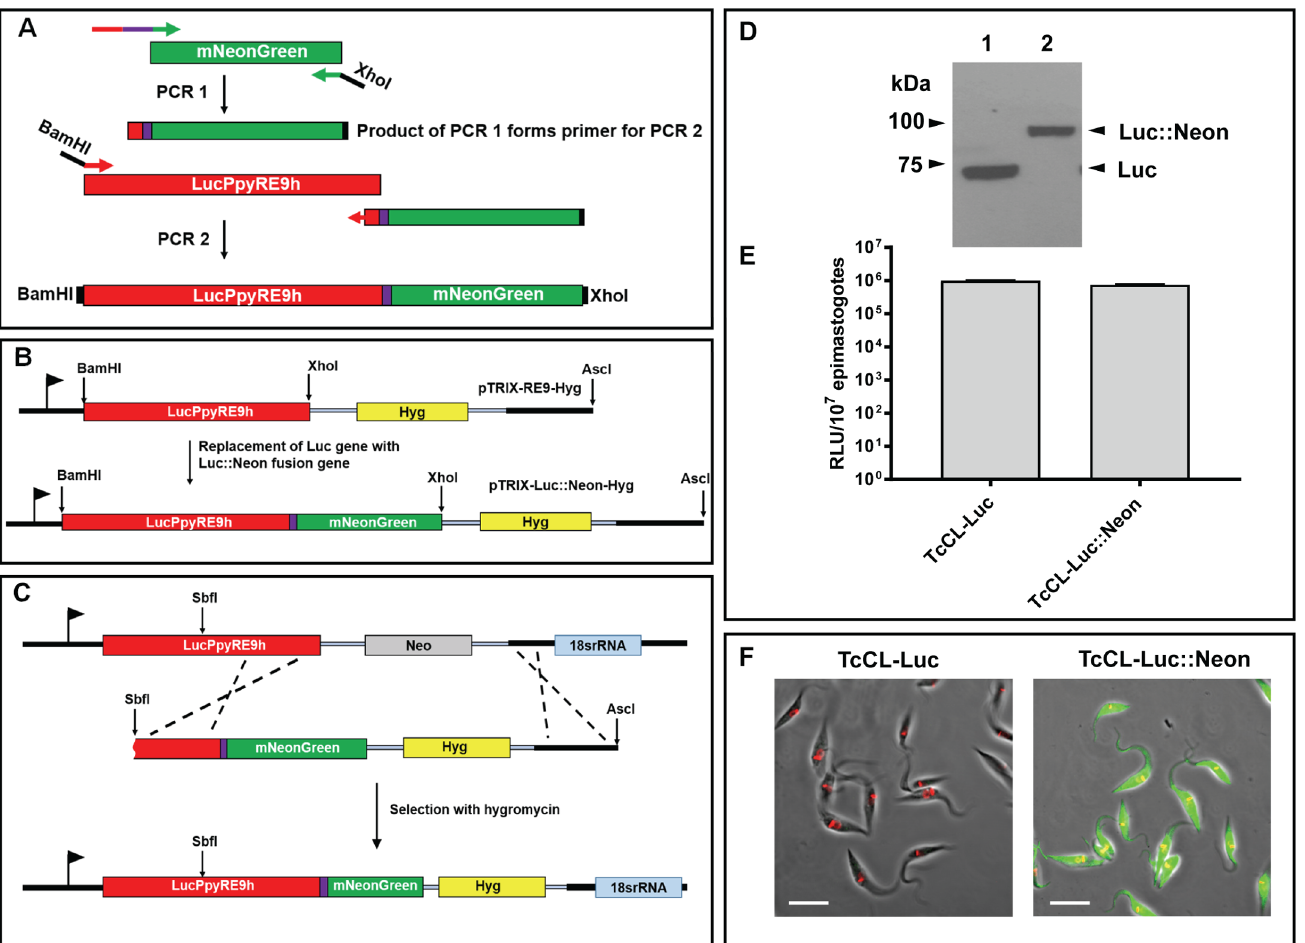
Fig 1. Generation and expression in T . cruzi of a chimeric bioluminescent–fluorescent fusion protein. A. Amplification of the mNeonGreen ORF and flanking targeting sequences, together with the coding sequence for an 8 amino-acid spacer peptide (purple line) (Methods) (PCR1). The product was used as the downstream primer to amplify the Luc::Neon fusion fragment (PCR2). The purple box indicates the 8 amino acid spacer peptide. B. The PCR2 product was inserted into plasmid pTRIX2-RE9-Hyg [15] to create pTRIX2-Luc::Neon-Hyg. C. SbfI/AscI linearised pTRIX2-Luc::Neon-Hyg was transfected into T . cruzi CL-Luc such that integration replaces the original luciferase sequence with the fusion gene, with the G418 resistance gene (Neo) exchanged for the gene encoding hygromycin resistance (Hyg). D. Western blot probed with a polyclonal anti-luciferase antibody (Promega). Lane 1, T . cruzi CL-Luc, the original bioluminescent strain; Lane 2, T . cruzi CL-Luc::Neon parasites expressing the 88 kDa fusion protein. E. Epimastigote luciferase activity in parasite lysates (Methods). Extracts were assayed in quadruplicate, data show mean activity, and error bars indicate standard deviation. F. Epimastigotes fixed in 2% paraformaldehyde and imaged on a Zeiss LSM 510 confocal microscope. The bar indicates 10μm. Only cells carrying the fusion protein exhibit green fluorescence. DNA is stained with DAPI (coloured red on images).